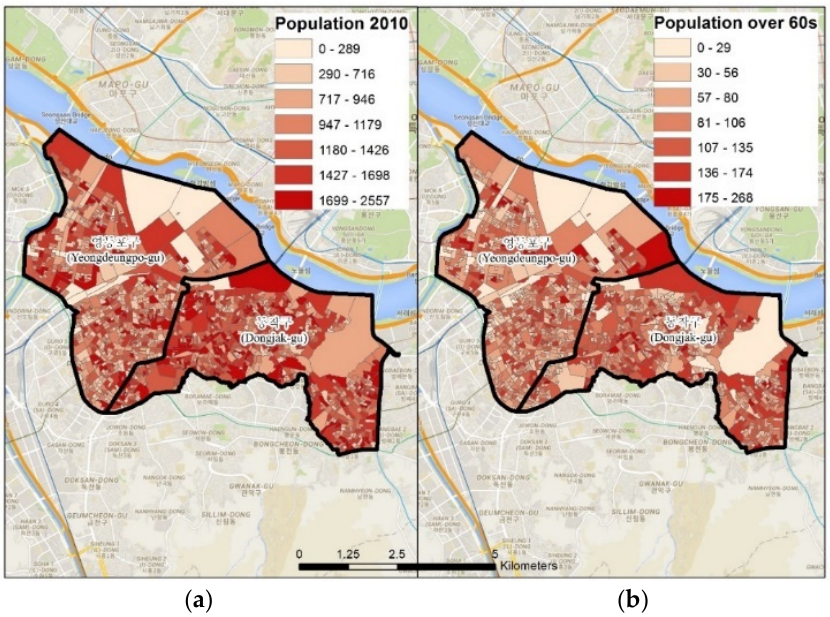
Figure 3. Study area census data. ( a ) entire population in the study area. ( b ) elderly population in the study area.